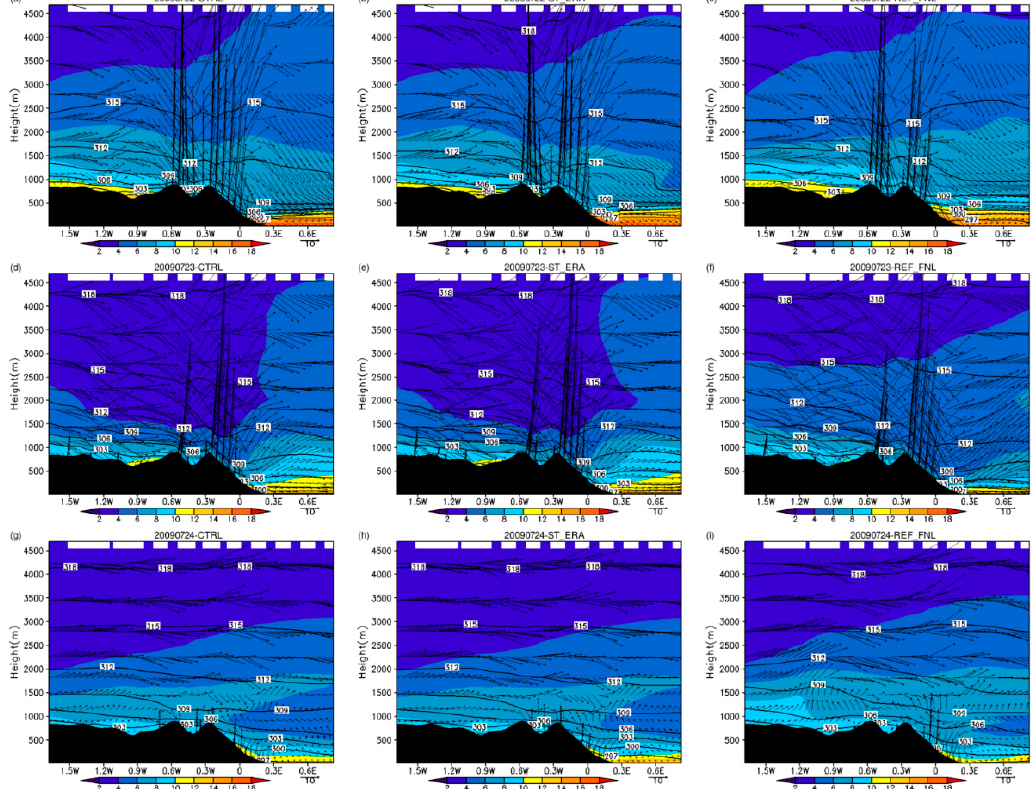
Figure 12. Vertical variation of the simulated potential temperature (K, contour), water vapor mixing ratio (g/kg; shaded) and wind vector (arrows) for a cross-section at latitude 38.7°N and at 06 UTC, considering the REF_ERA, ST_ERA and REF_FNL simulations for the whole simulation period: 22 July—REF_ERA ( a ); 22 July—ST_ERA ( b ); 22 July—REF_FNL ( c ); 23 July—REF_ERA ( d